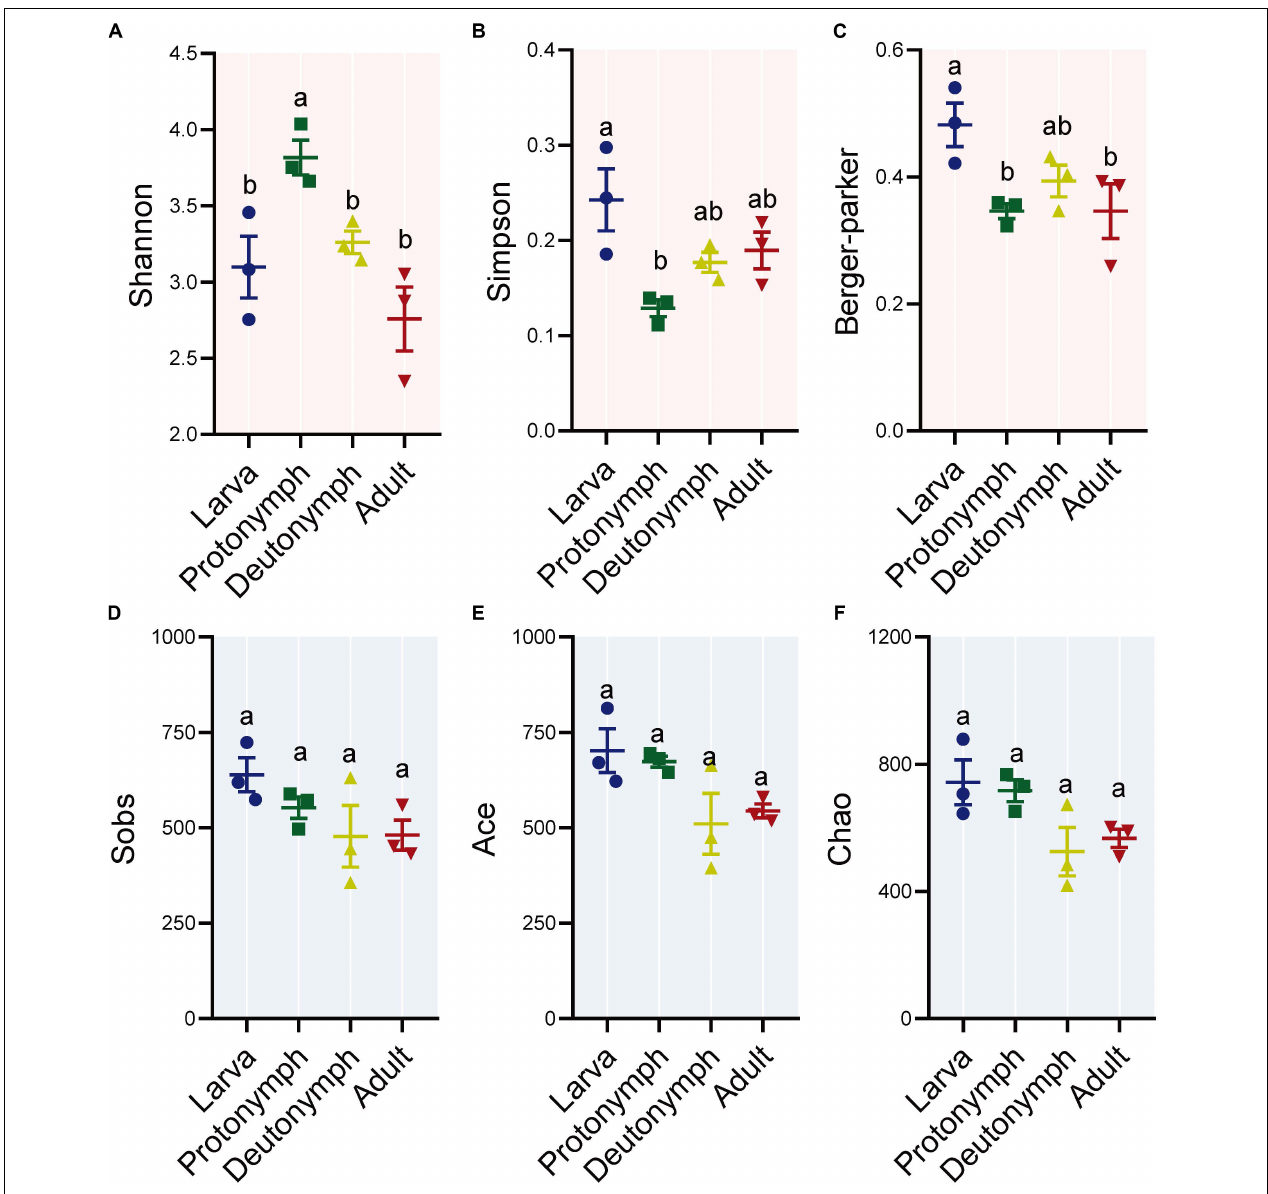
FIGURE 1 | Alpha diversity of bacterial communities across the lifespan of P. citri . The Shannon (A) , Simpson (B) , and Berger-Parker (C) indexes for bacterial diversity, and observed species (Sobs, D ), ACE (E) and, Chao (F) indexes for species richness were applied. All n = 3. Different lowercase letters denote significant differences between different life stages ( P < 0.05, post hoc Duncan’s Multiple Range Test [DMRT]). Plots showed means ± standard error of mean (SEM).